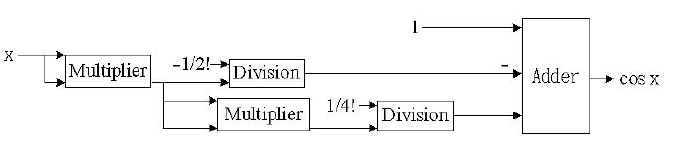
Figure 12. Block diagram of the cosine function with the Taylor expansion.